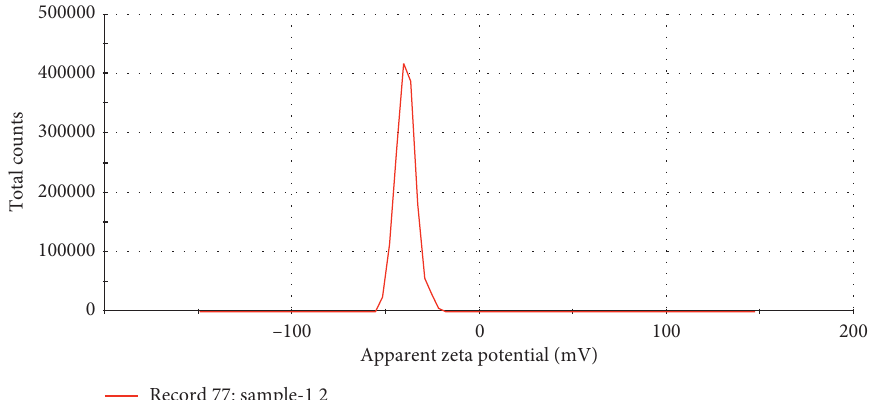
Figure 3: Zeta potential distribution of DFS-NE ( ζ � − 39.06mV).